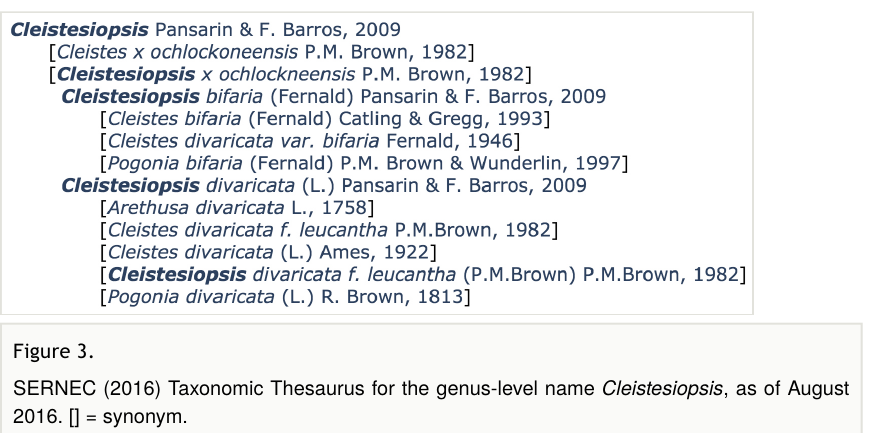
Figure 3. SERNEC (2016) Taxonomic Thesaurus for the genus-level name Cleistesiopsis , as of August 2016. [] =